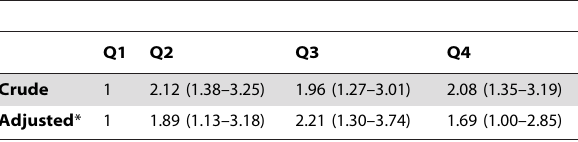
Table 5. Risk of hyperhomocysteinemia with quartiles of blood Pb (95%